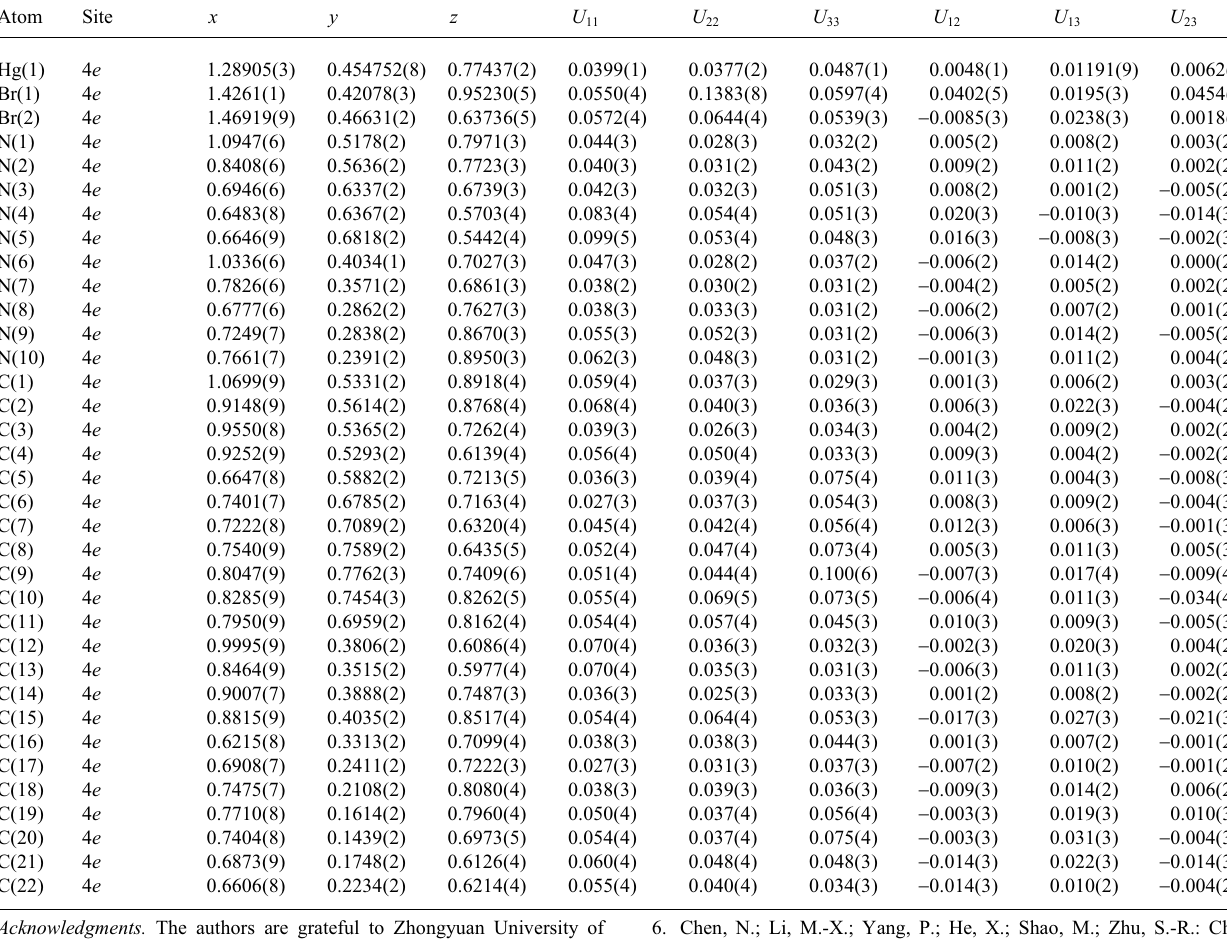
Table 3. Atomic coordinates and displacement parameters (in Å 2 )